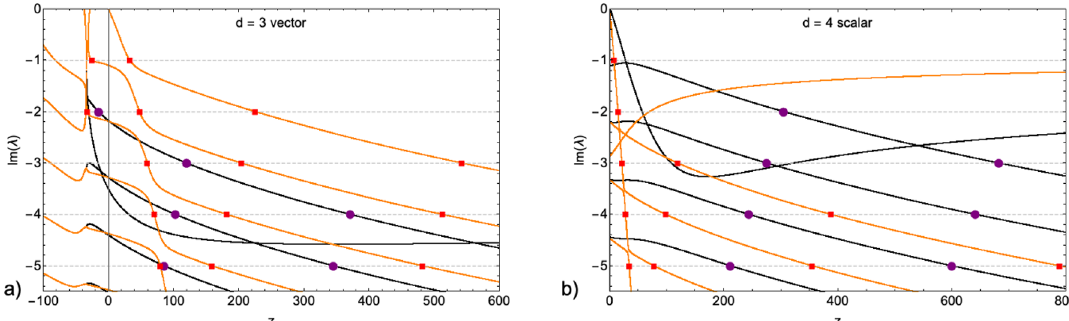
Figure 5 . Comparison of the pole skipping points at the Matsubara frequencies with the full dispersion relations for real z . Panel (a): the orange (black) lines correspond to the shear (trans- verse) channel for d = 3 ; ~ Q = Q=Q max = 0 : 9. Panel (b): the orange (black) lines correspond to the di(cid:11)usion (sound) channel for d = 4 ; ~ Q = Q=Q max = 0 : 9. In both panels, the red and purple points correspond to the locations of pole skipping and it is easy to see they all lie along dispersion relations, either of hydrodynamic or non-hydrodynamic QNMs. Note that complex pole skipping points are not visible on this